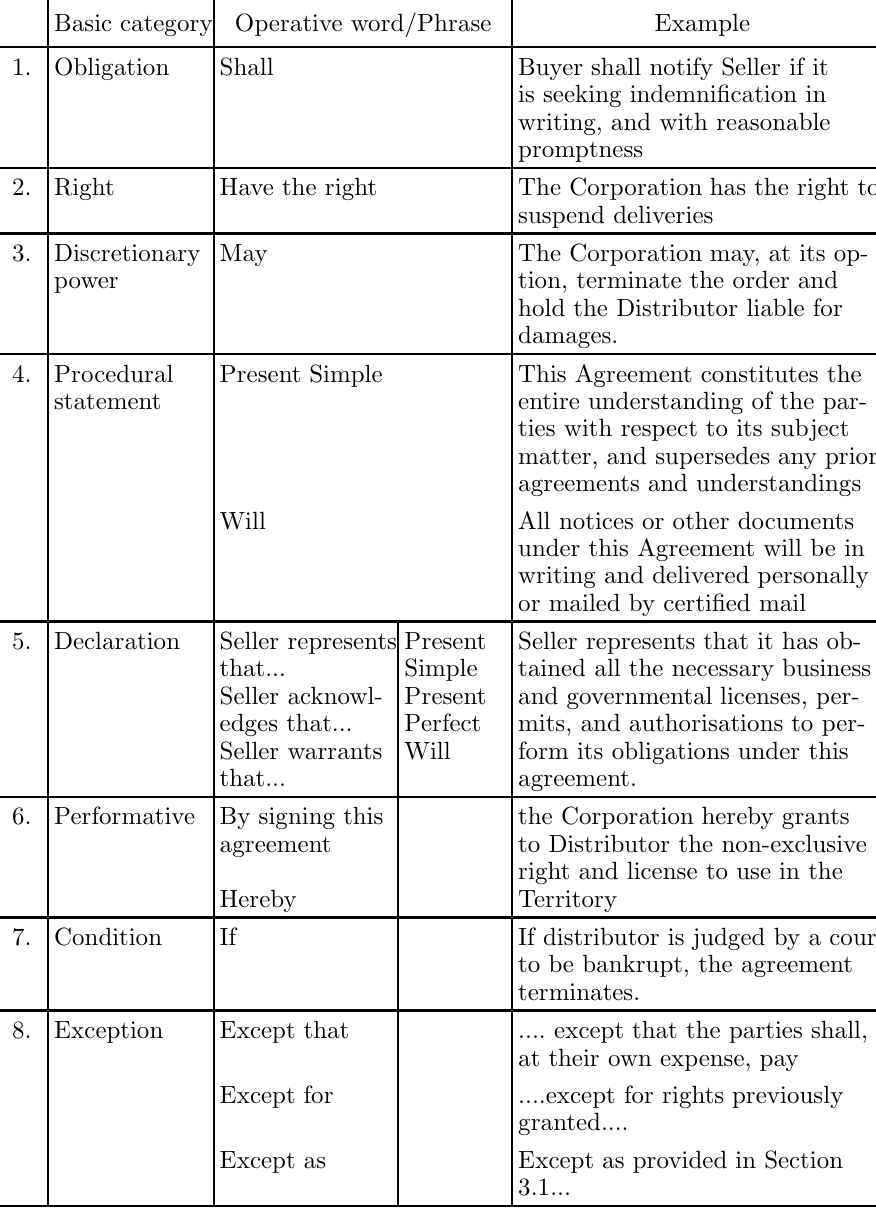
Operative Words and Phrases of the Basic Contract Categories Basic category Operative